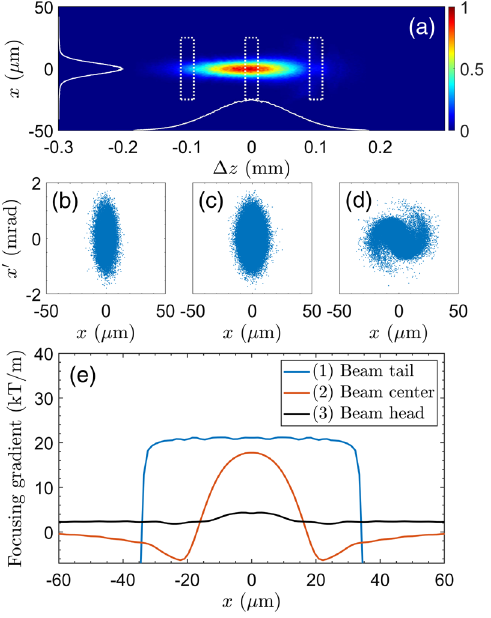
FIG. 20. (a) Slice distribution of the electron beam after propagation through the 1 m plasma source. The beam head is placed at positive Δ z , while the beam tail is placed at negative Δ z . The dashed boxes indicate the regions of the slice distributions. (b, c, d) Slice horizontal phase space at different slice locations at the tail, center, and head of the beam, respectively. (e) Focusing gradient along three different electron-beam